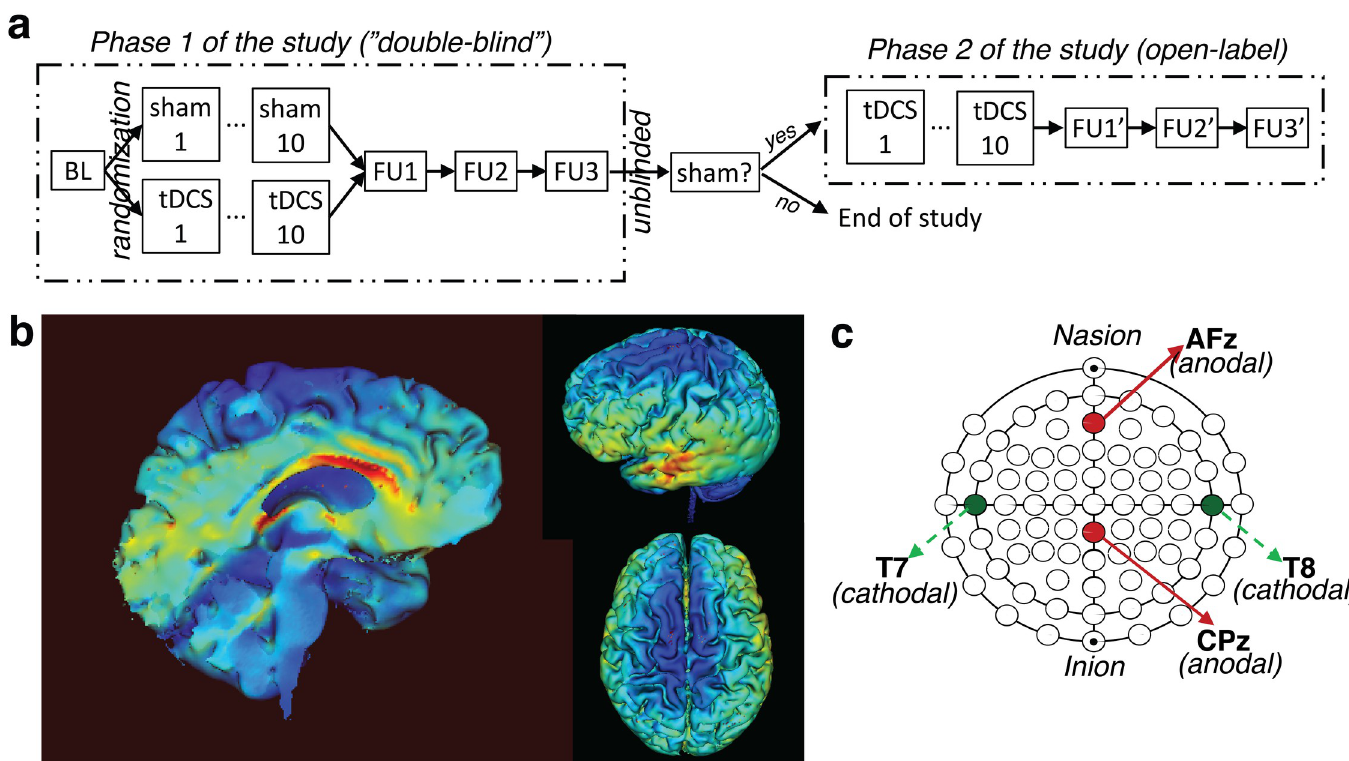
Fig 1. Experimental design and tDCS simulation and setup. (a) This partial crossover study had two study phases. During Phase 1, participants were randomly assigned to receive sham or cingulate tDCS based on age and sex at birth. The treatment assignments were unknown to the participants as well as the study team during Phase 1. There were ten tDCS treatment sessions, with one per weekday over the course of 2–3 weeks. Neuropsychology and MRI data were collected from four additional study visits, including one baseline visit prior to the first tDCS treatment session (BL) and three follow-up visits (FU1/FU2/FU3, which were approximately one-week, three- weeks, and three-months after the last tDCS treatment session, respectively). After the FU3 visit, the treatment assignments were unblinded. The study was finished for participants who received active cingulate tDCS during Phase 1. In contrast, participants who received sham tDCS during Phase 1 were invited back to participate in Phase 2 of the study (open-label cingulate tDCS treatment). The study design of Phase 2 was identical to that of Phase 1, except that FU3 from Phase 1 served as BL for Phase 2. (b) Model of the induced electrical field on a typical brain, shown as field intensity (V/m) irrespective of the direction of current flow (the range of field intensity: 0 to 0.43 V/m). (c) The locations of anodal and cathodal electrodes with a 2x2 high-definition tDCS setup, which were based on the simulations in ( b ). Electrode locations were based on the international 10–10 electroencephalography (EEG)